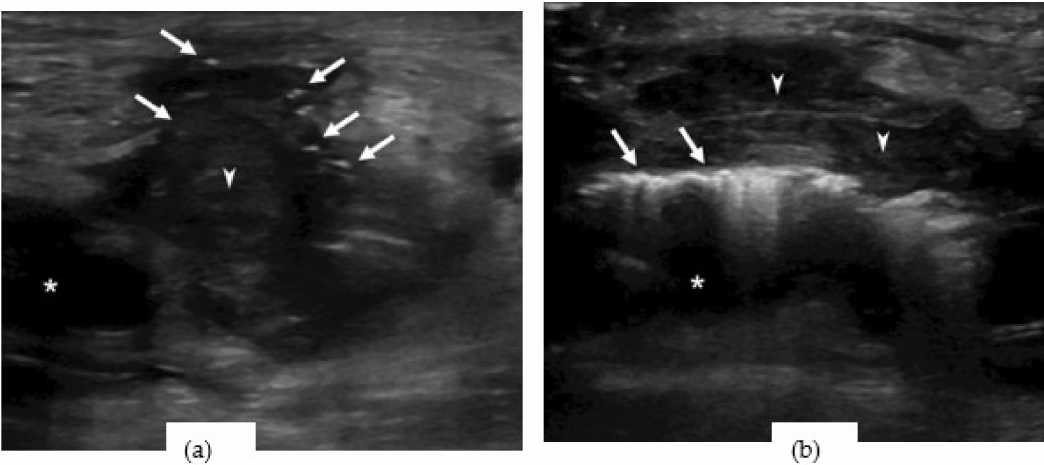
Figure 1. Point-of-care ultrasound revealed ( a ) A hypoechoic mass (arrowhead) surrounding with a dirty shadow (arrows) around the femoral artery (asterisk). ( b ) A hypoechoic mass (arrowhead) and an echogenic rim with dirty posterior shadowing (arrows) along the femoral artery (asterisk).